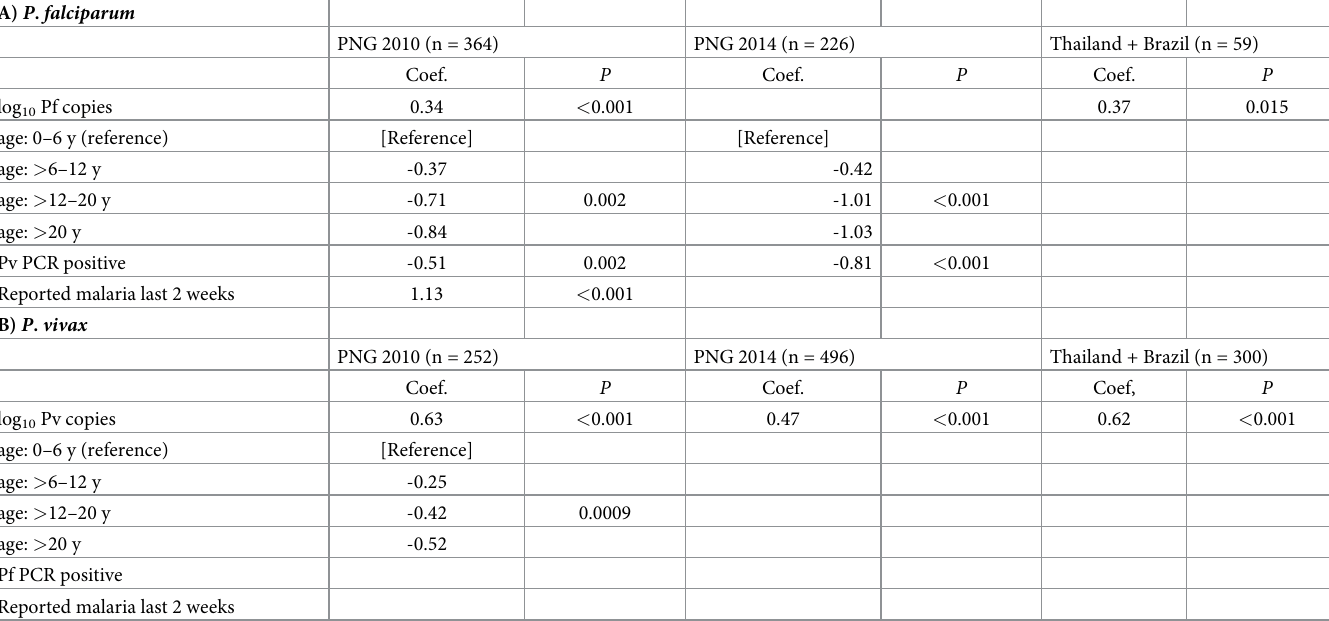
Table 4. Mutlivarable predictors of P . falciparum and P . vivax gametocyte density under different transmission scenarios. A) P .